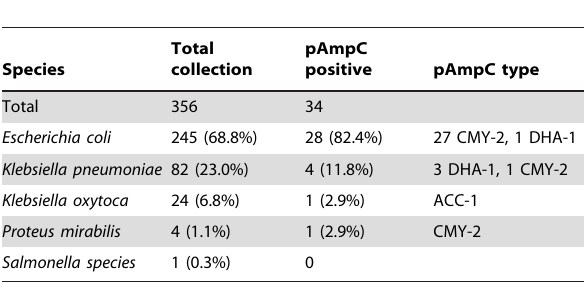
Table 1. AmpC production in 356 highly resistant enterobacterial